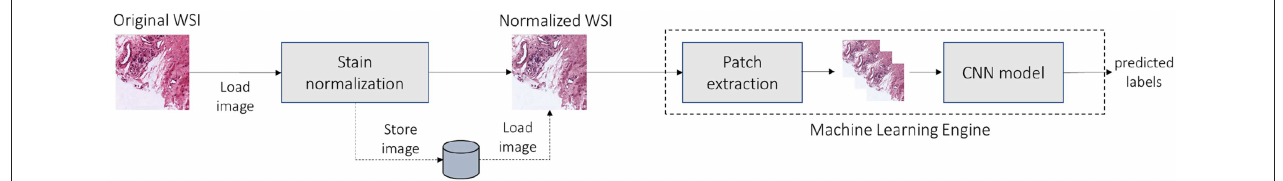
FIGURE 1 | Exemplary ML-based pipeline: stain-normalized WSIs feed an ML engine for tumor